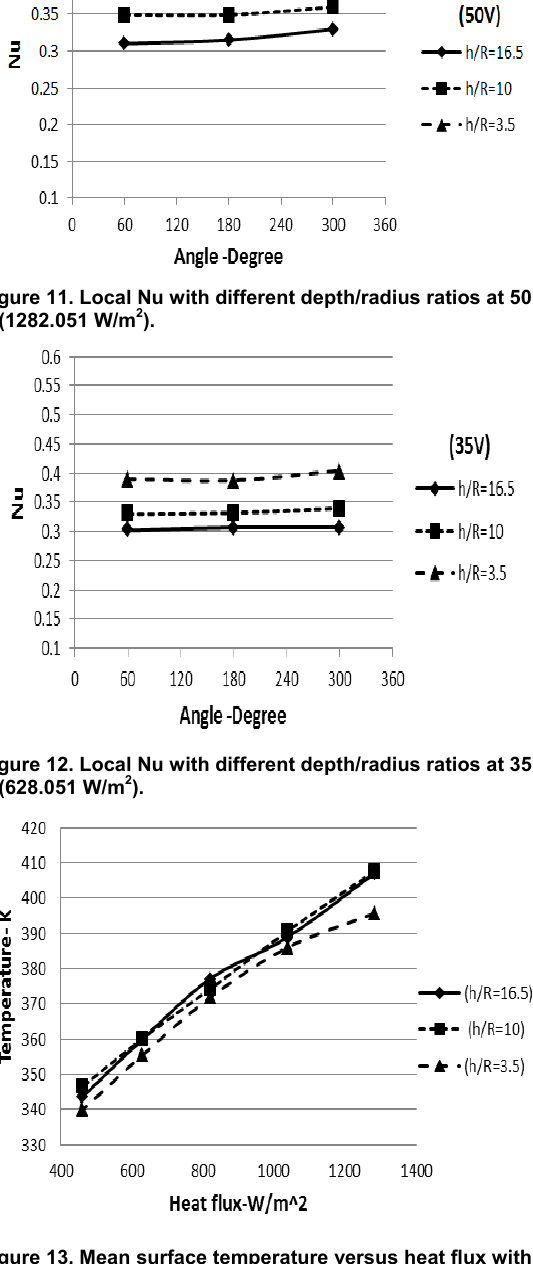
Figure 13. Mean surface temperature versus heat flux with different depth/radius